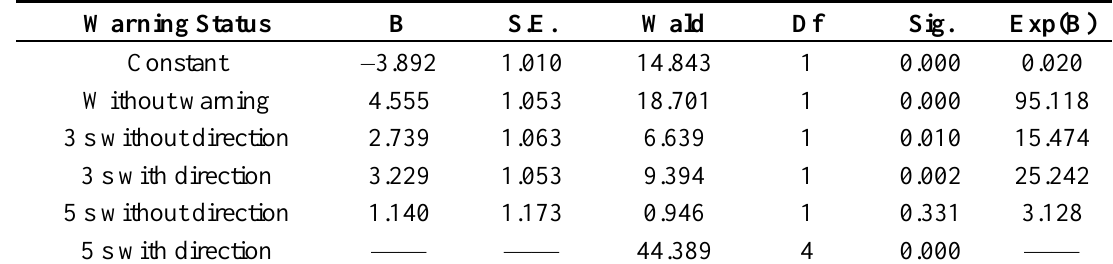
Table 5. Results of the logistic regression analysis.